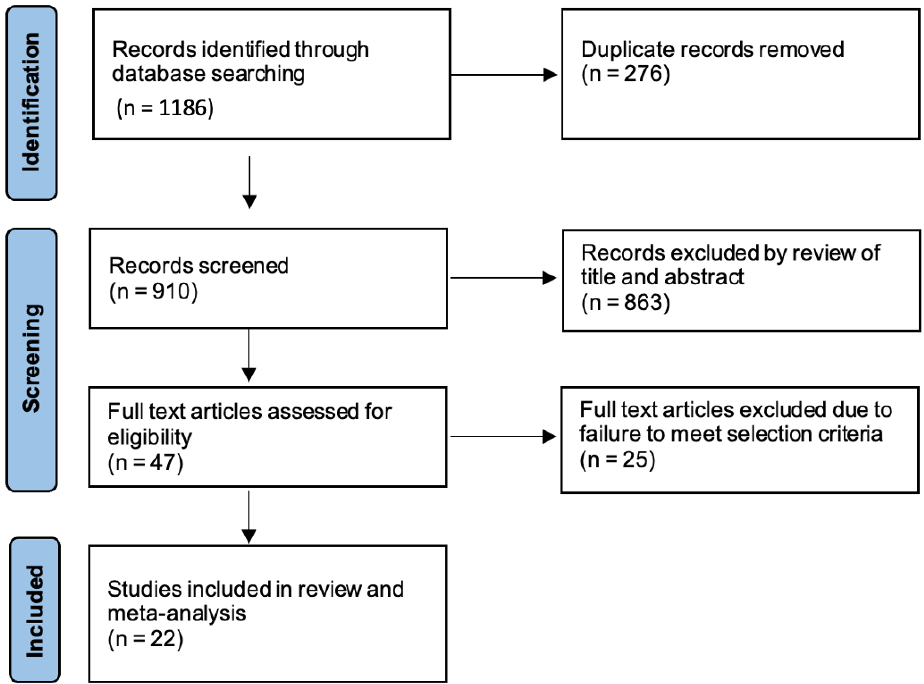
Figure 1. PRISMA flowchart detailing literature search process for studies comparing RVATS and open thoracotomy for non-small cell lung cancer.